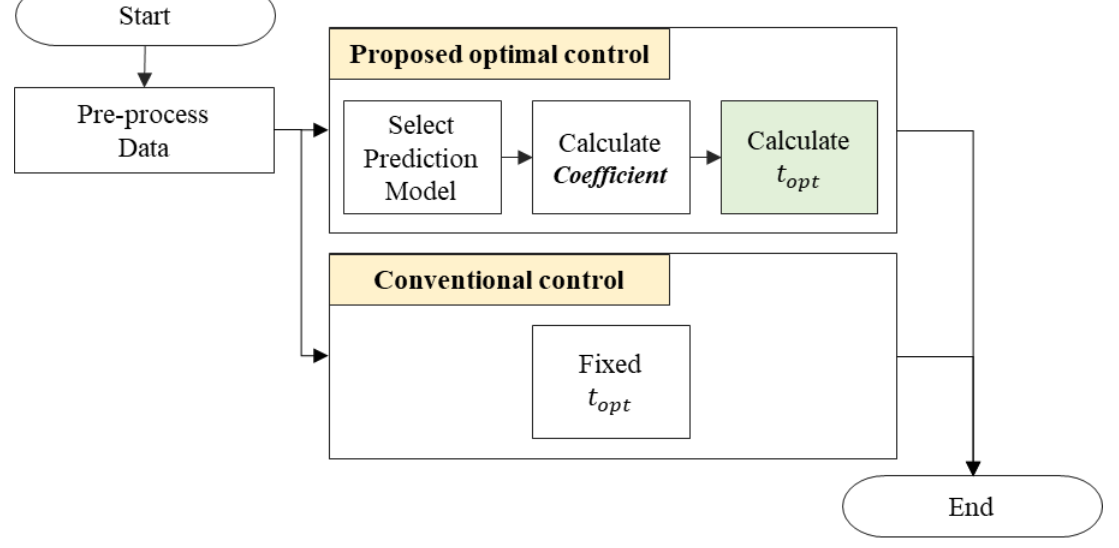
Figure 4. Comparison of the proposed optimal and conventional control strategies.